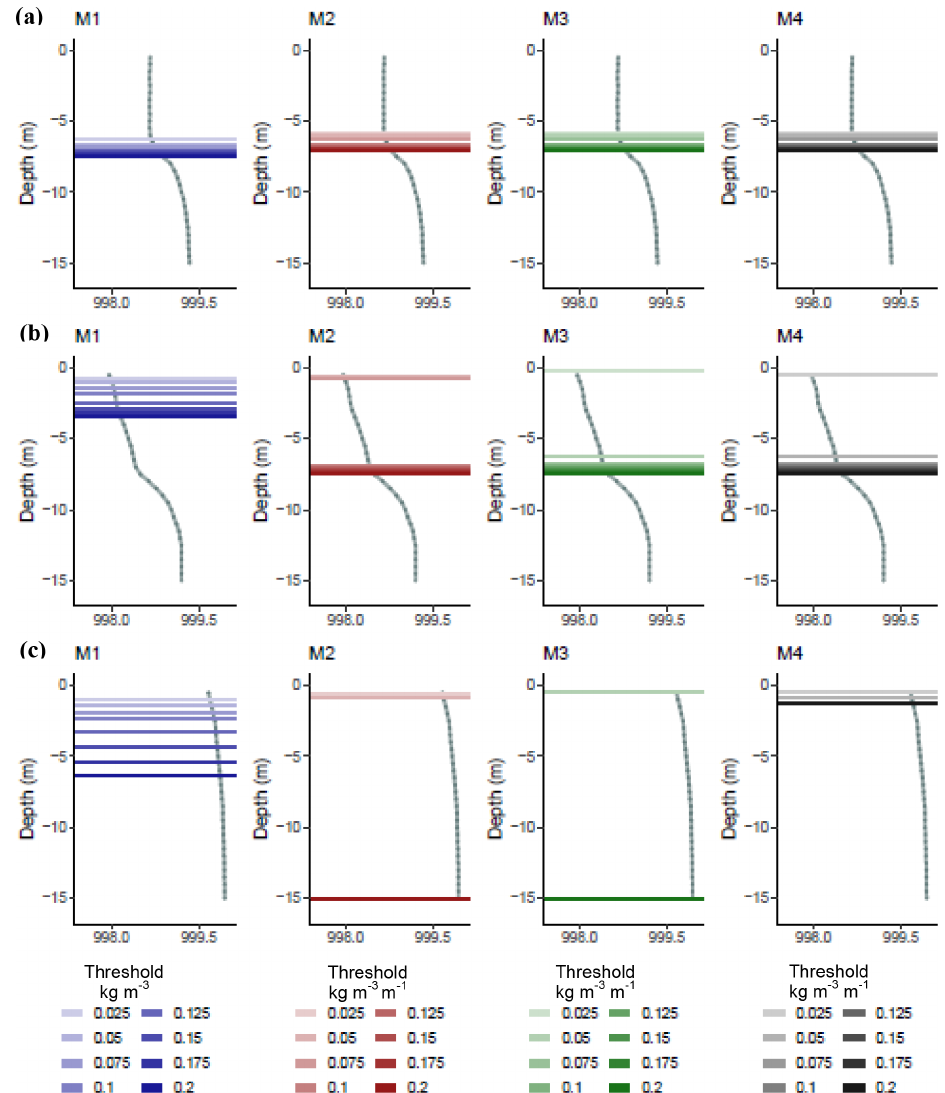
Figure 4. An example of water column profiles with the epilimnion depth estimates superimposed (horizontal lines) for all profile-based epilimnion depth methods calculated using the full range of thresholds for each. The water columns can be categorised as a three-layered water column structure (a) , an intensely stratified profile (b) , and a near-isothermal profile (c) , which are all from Erken lake only. Table 2. Summary of statistics for each method, showing the mean (m) and standard error of the mean in brackets, minimum (i.e. shal- lowest estimate) (m), maximum (i.e. deepest estimate) (m), interquartile range (IQR, m) of the April–October epilimnion depth estimates (summarised from the results shown in Fig. 6a), and the mean Pearson’s correlation coefficient ( r ) for each method, representing the mean correlation for all possible combinations between threshold values for Lough Feeagh and Erken